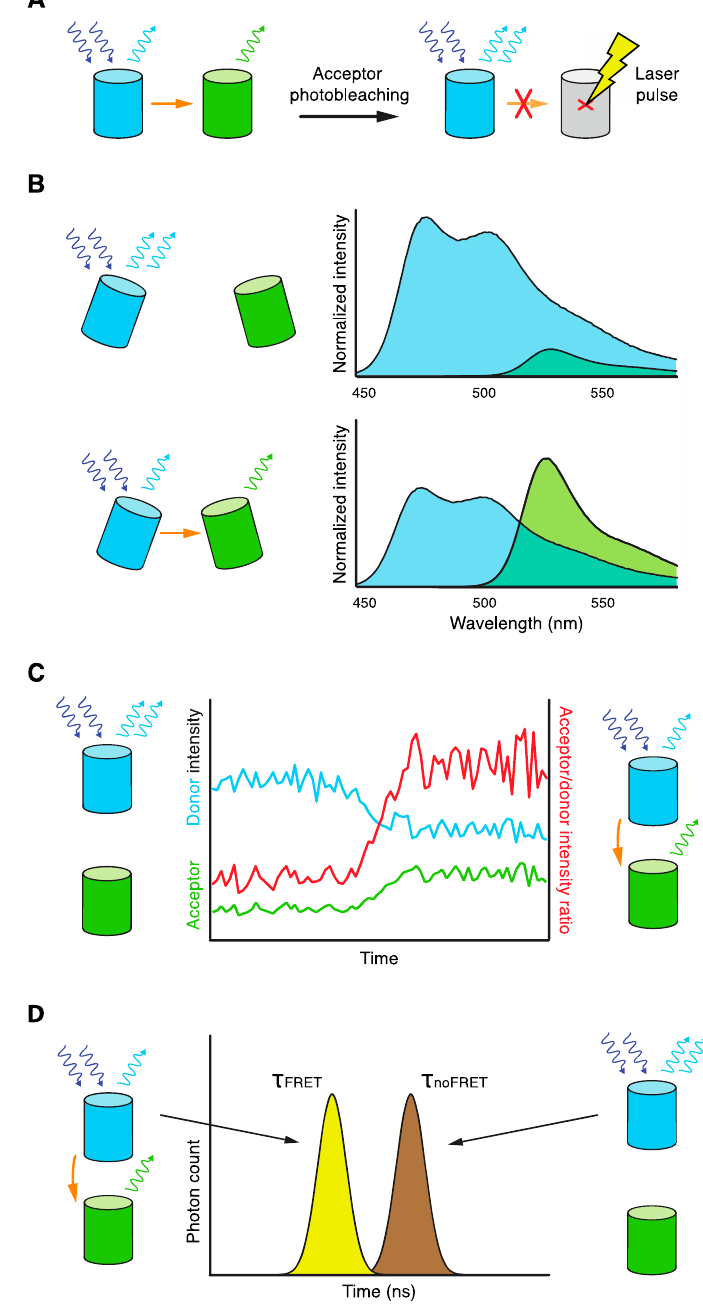
Figure 4. Basic principles of FRET microscopy techniques. ( A ) Acceptor photobleaching. Increase in donor fluorescence after the photo-inactivation of acceptor FP by a laser signalizes FRET. ( B ) Sensitized emission. FRET causes enhanced emission of acceptor fluorescence and decreased emission of donor fluorescence. These changes can be measured either over the whole spectrum (spectral FRET) or in specific wavelength windows (tri-cube FRET). ( C ) Ratiometric FRET. The simplest readout of sensitized emission, when the ratio of acceptor/donor fluorescence is followed over time. ( D ) FRET-FLIM. FRET decreases the fluorescence lifetime of the donor. Pools of FRET-involved and FRET-absent donor molecules are discernible by their different fluorescence lifetimes.